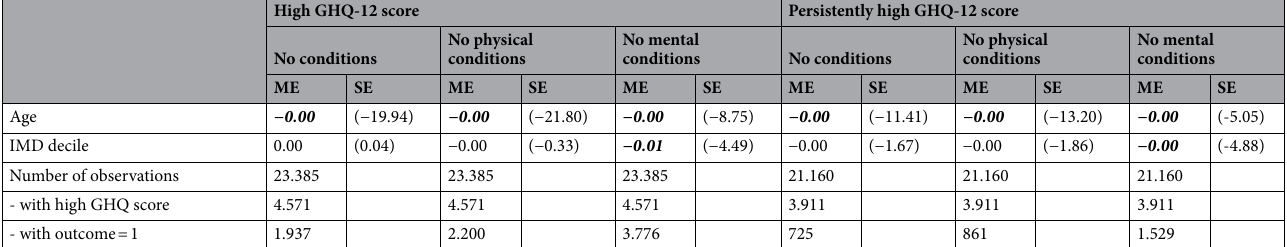
Table 5. Regressions examining the associations between not reporting diagnosed health conditions and having a high GHQ-12 score or persistently high GHQ-12 score. Notes: Population estimates for England and Wales. Standard errors (SE) adjusted for clustering and stratification. All estimates that reach statistical significance ( p < 0.05) in italics; estimates in bold are statistically significant at p < 0.001.Models analysing persistently high GHQ-12 score use information collected in Wave 9, and longitudinal weights are applied to account for unequal repeat response probabilities. Source: Understanding Society (2020), Wave 10, linked with ONSPD (Nov 2020) and Index for Multiple Deprivation 2019 at the LSOA 2011